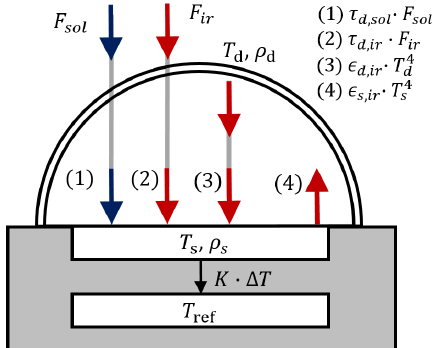
Figure 1. Simplified radiative energy budget of a broadband ra- diometer composed of (1) the transmitted solar irradiance, (2) the transmitted thermal–infrared irradiance, (3) the irradiance emitted by the dome, and (4) the irradiance emitted by the sensor. Blue ar- rows indicate solar radiation, and red arrows are used for thermal– infrared